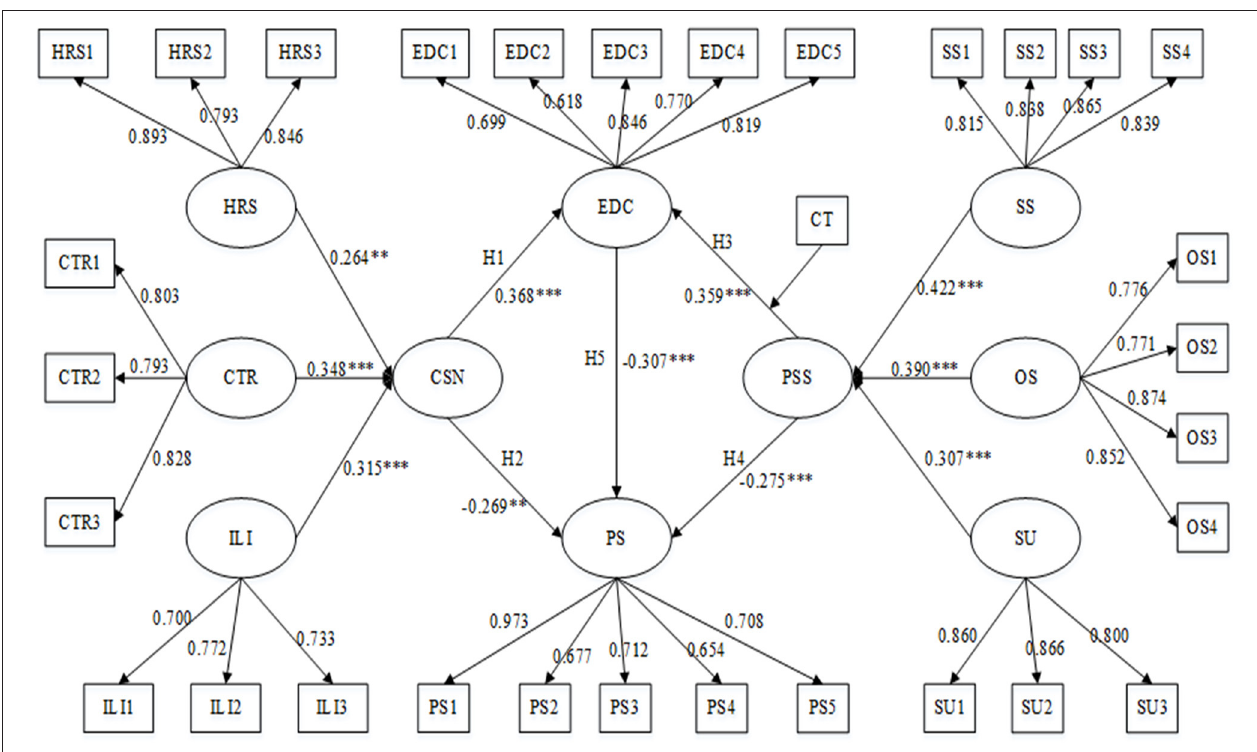
FIGURE 4 | The results of the full model.